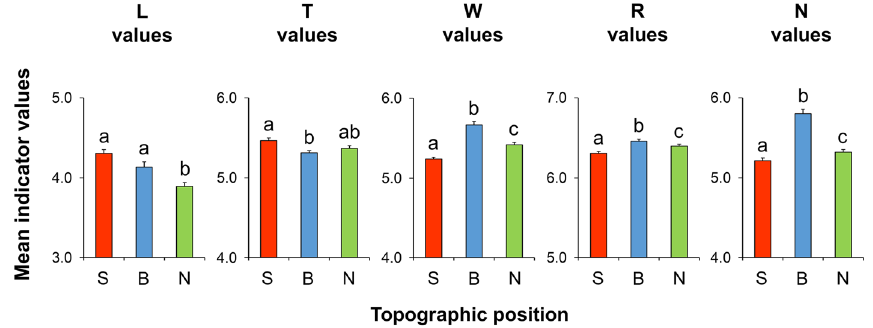
Fig. 9 Mean Ellenberg indicator values (L: light availability, T: temperature, W: soil moisture, R: soil reaction, and N: nutrient availability) in the plots of topographic positions in dolines (S: south-facing slope, B: bottom, and N: north-facing slope) (mean LMMs with Bonferroni post hoc tests) are indicated by different lower case (a–c)